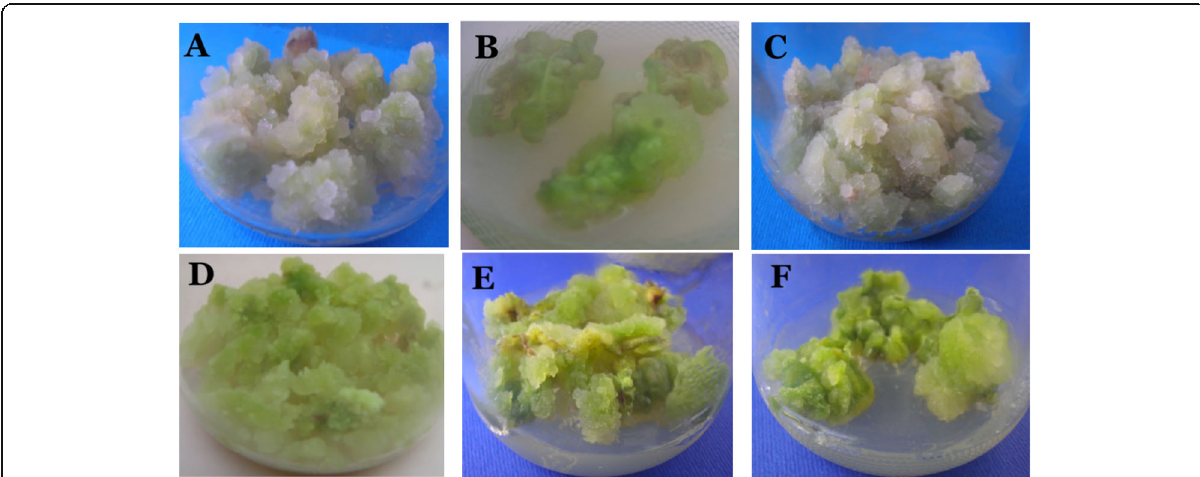
Fig. 1 Callus induction from leaf explant on MS medium containing:2.5 mg/l BA + 1.0 mg/l NAA ( a ), 0.25 mg/l BA + 0.5 mg/l NAA ( b ), 1.0 mg/l BA + 0.5 mg/l NAA ( c ), green friable callus grown on MS + 2.5 mg/l BA + 0.5 mg/l NAA ( d ), creamy yellowish compact callus grown on MS + 0.25,